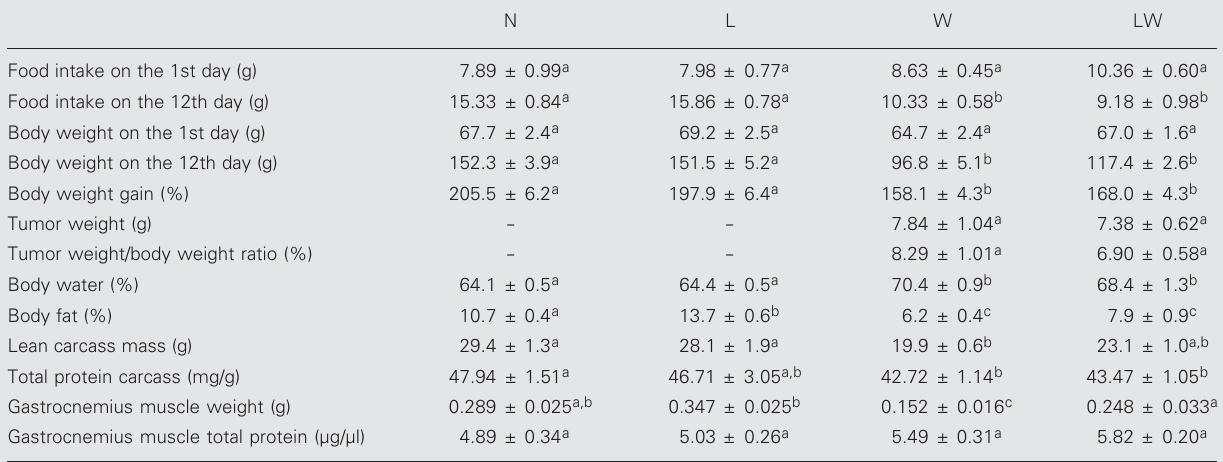
Table 1. Effects of leucine-supplemented diets on the characteristics of tumor-bearing